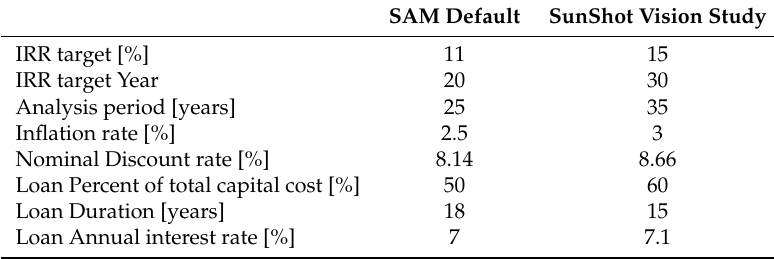
Table 4. Financial parameters employed in the SAM’s default and SunShot Vision cases. The parameters that are not reported here are set to the values used by SAM’s default model in Table 6.